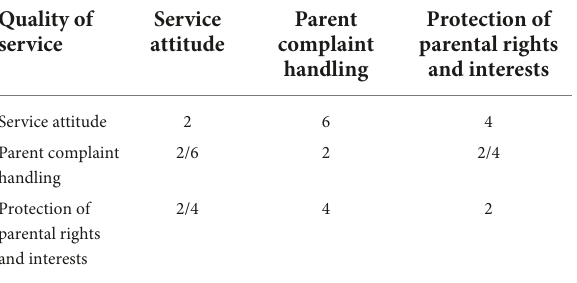
TABLE 1 Index comparison matrix.